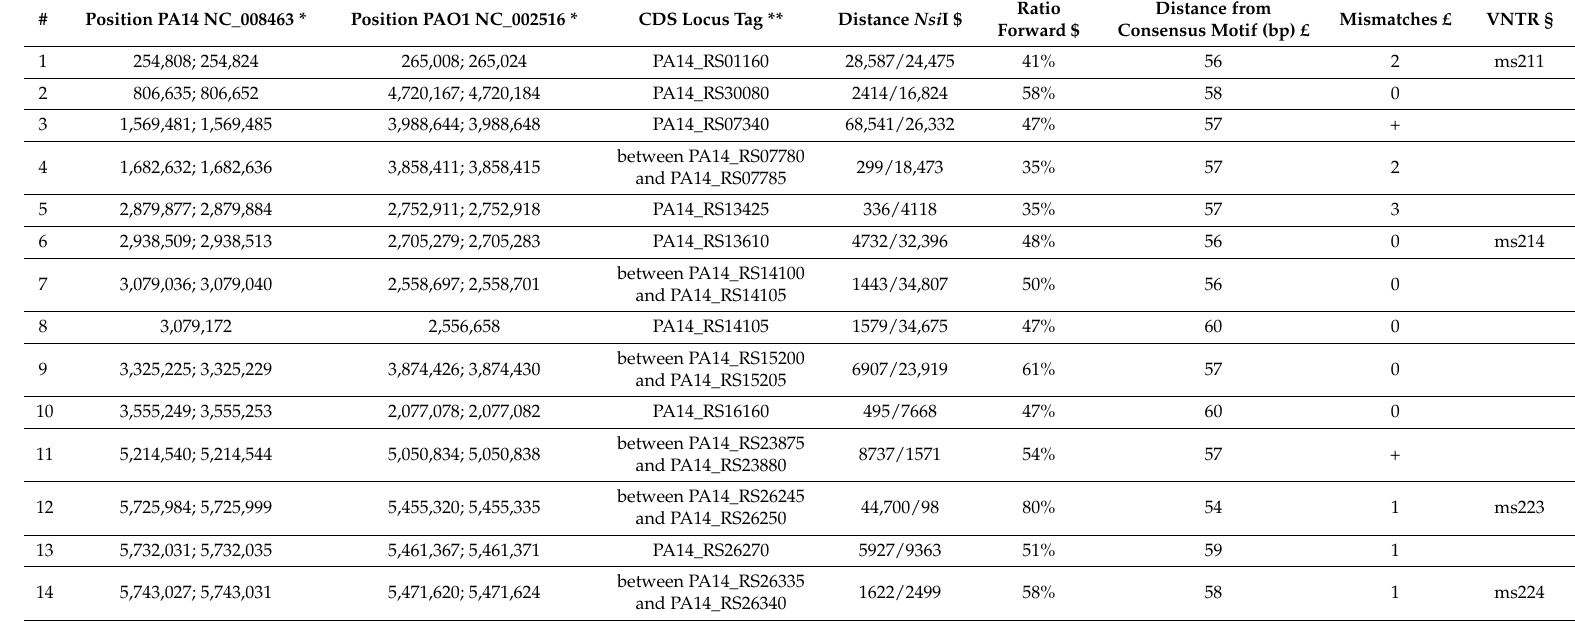
Table 2. A list of the 14 main Ab30 insertion hotspots (at least one nucleotide position with more than 3000